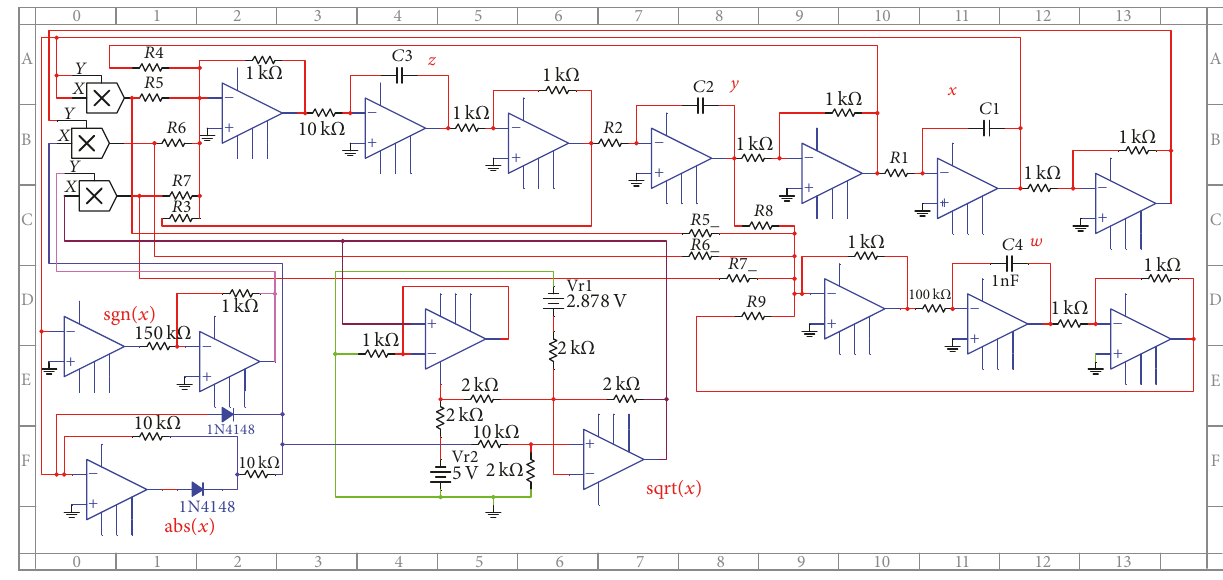
Figure 9: Circuit design of the hyperchaotic system with